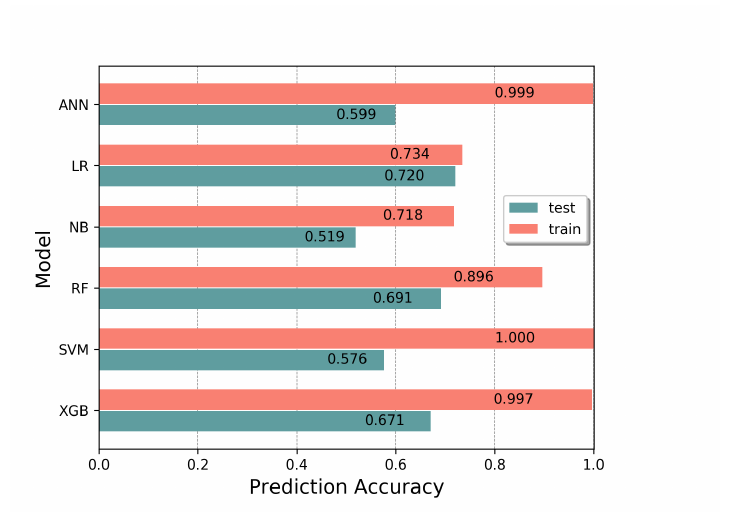
Figure 5. Accuracies with all features on training/test data.